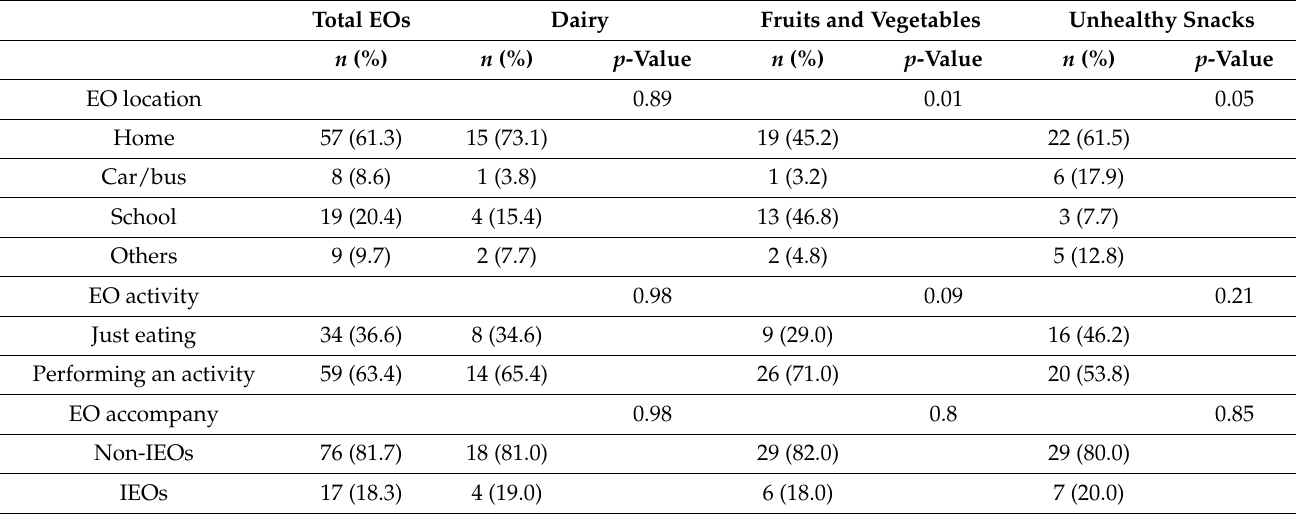
Table 7. Environmental factors and eating occasions of